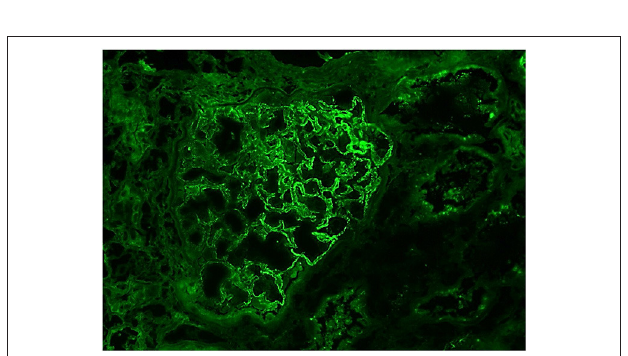
FIGURE 3 | IgG, 40X: The glomerulus demonstrates mesangial and diffuse global, granular capillary loop staining.